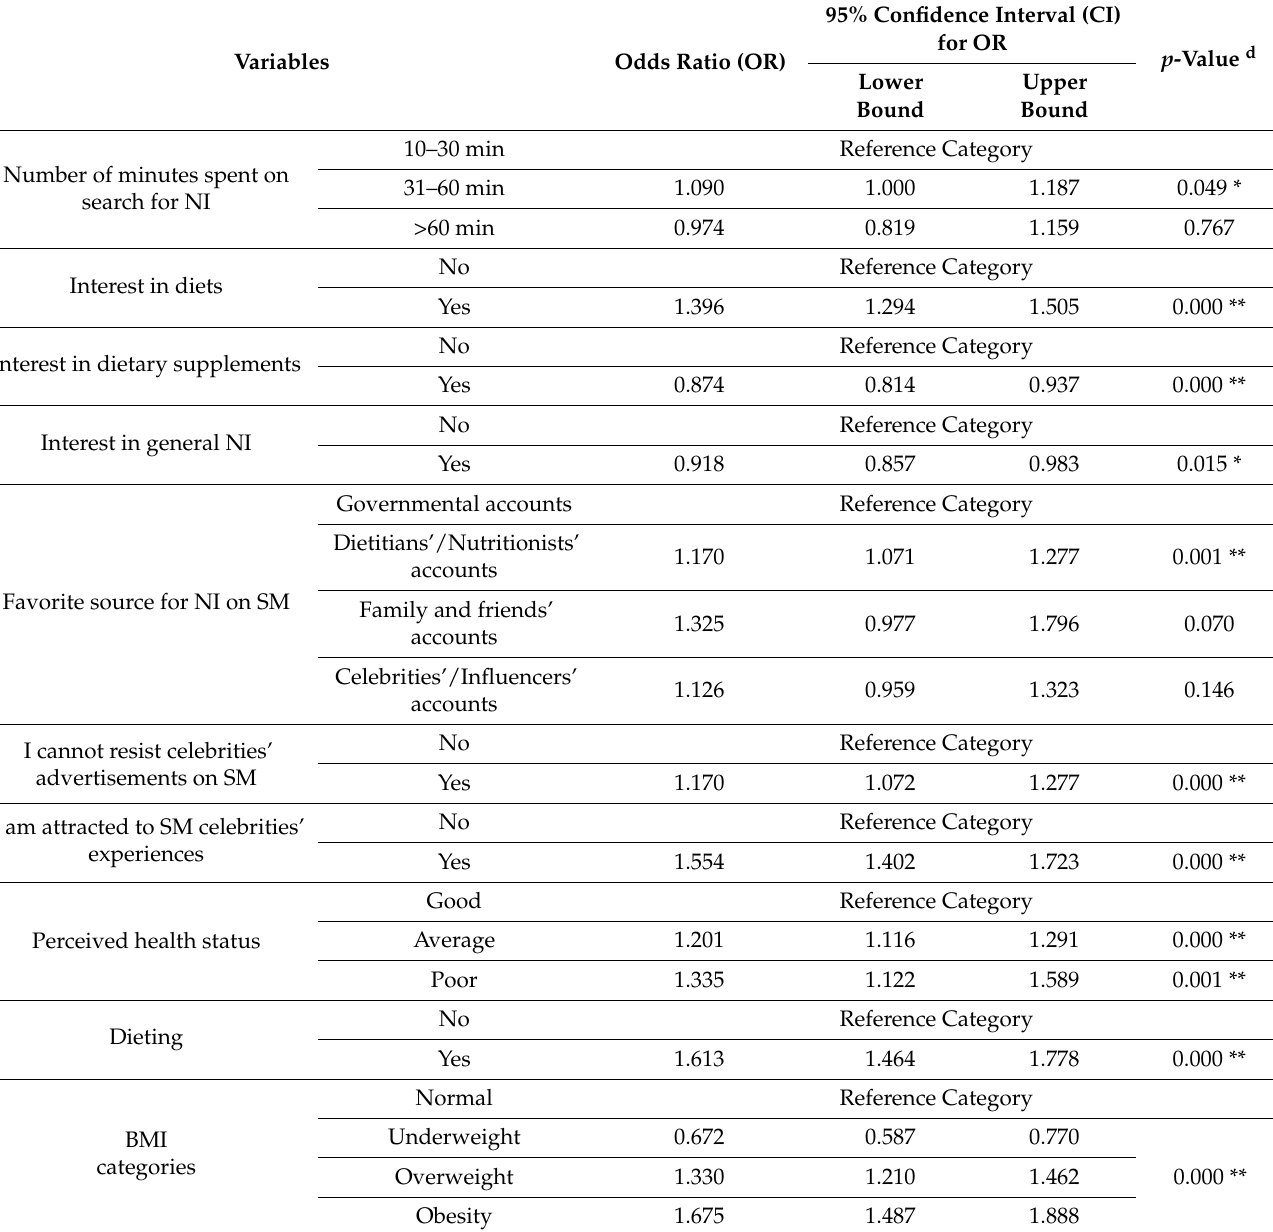
Table 4. Risk Factors for Eating